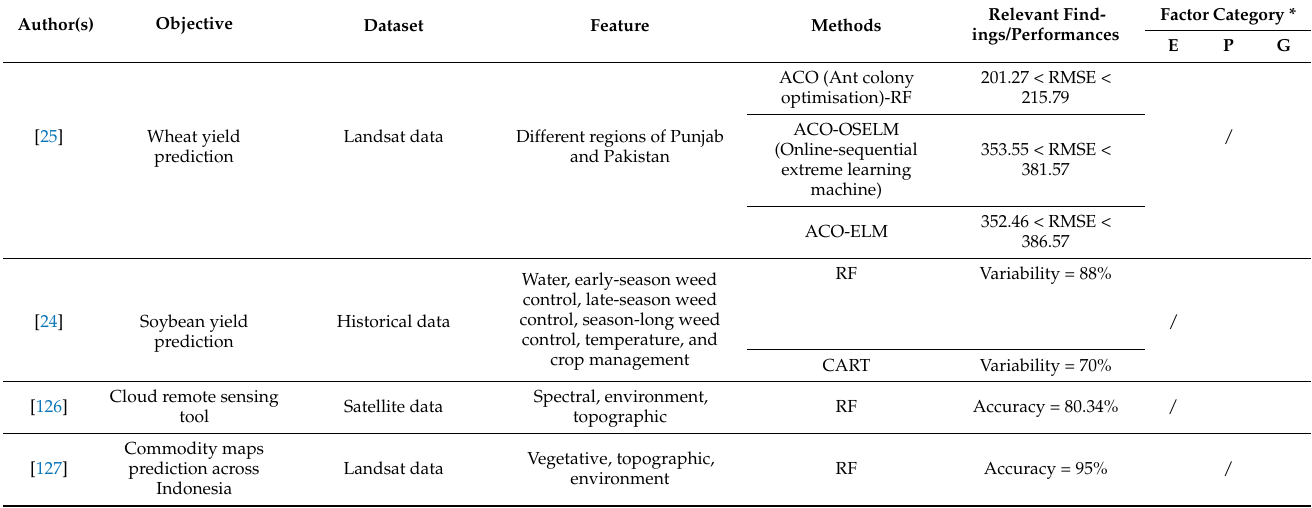
Table 6. RF prediction of crops and palm